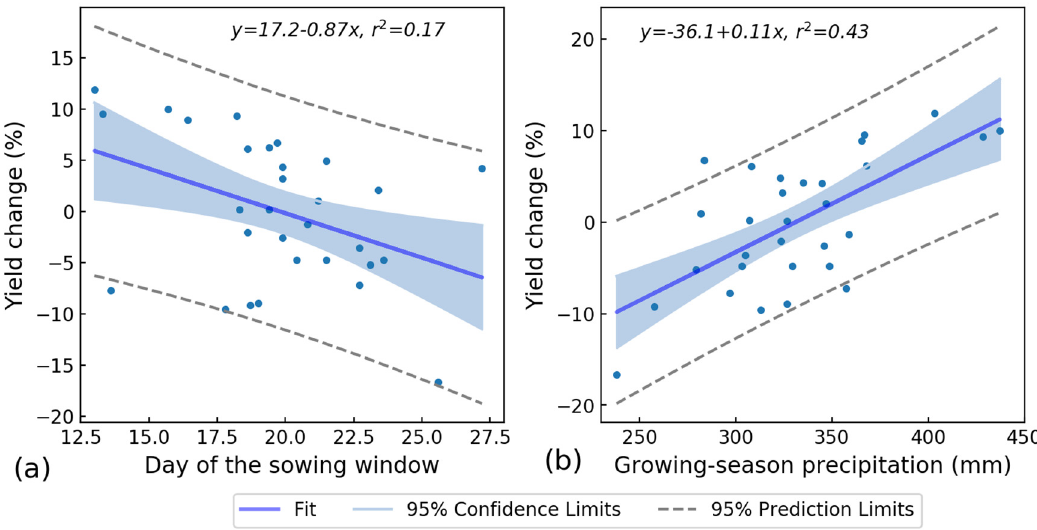
Figure 4. Relationships between simulated national maize yields and ( a ) sowing date and ( b ) growing-season rainfall. Yield, sowing date, and growing-season rainfall are national means across the country, weighted by gridded maize area of 2000 [31]. Sowing date is normalized as the day of the sowing window as in Figure